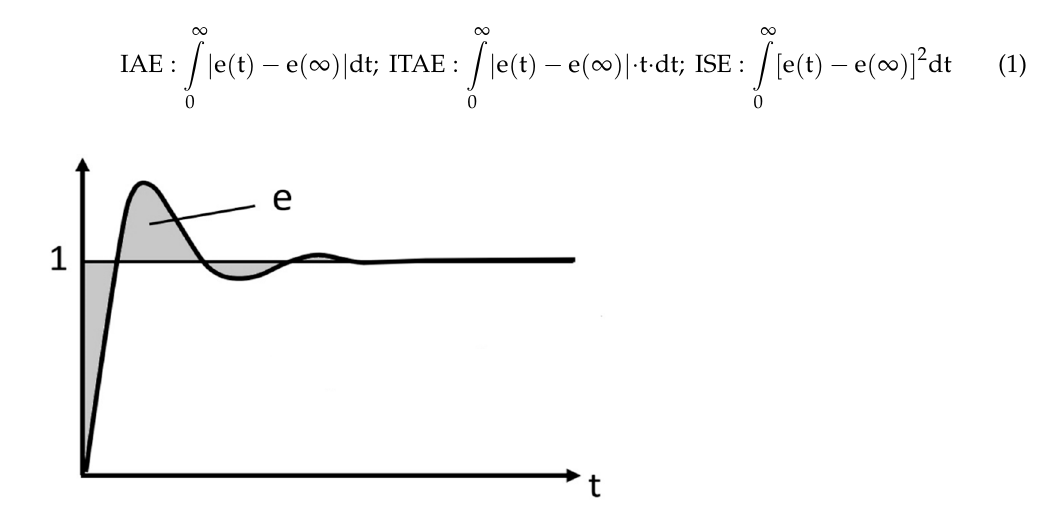
Figure 3. Illustration of the control error e(t) in the closed loop, as a basis for the IAE, ITAE and ISE